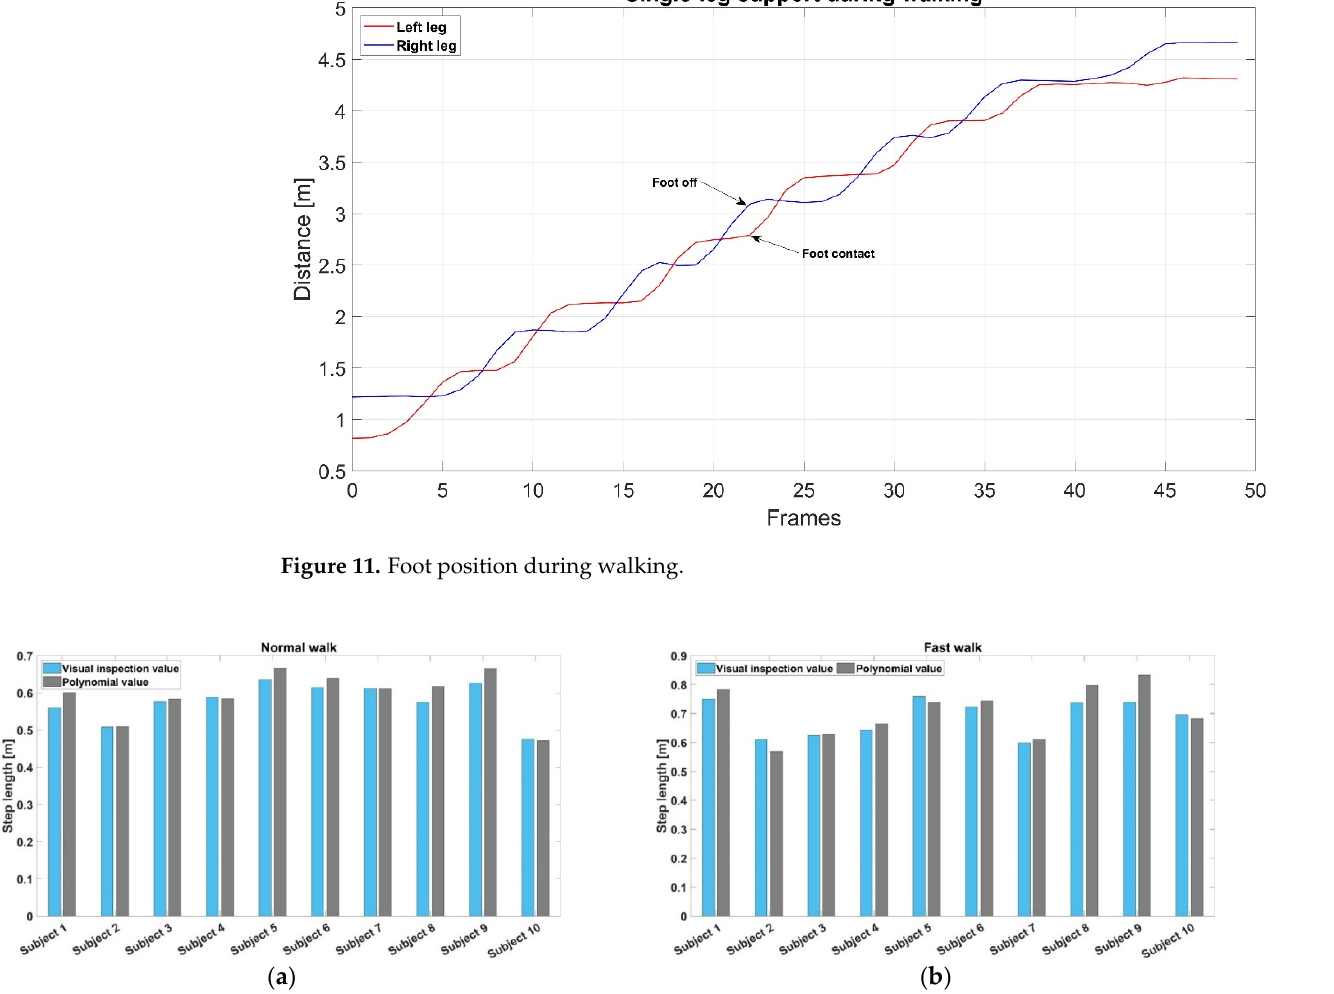
Figure 12. Experimental results obtained from both a fast and normal walking speed: ( a ) the differences in step length value between the visual inspection method and polynomial fitting curve method for normal walk; ( b ) the differences in step length value between the visual inspection method and polynomial fitting curve method for fast walk.